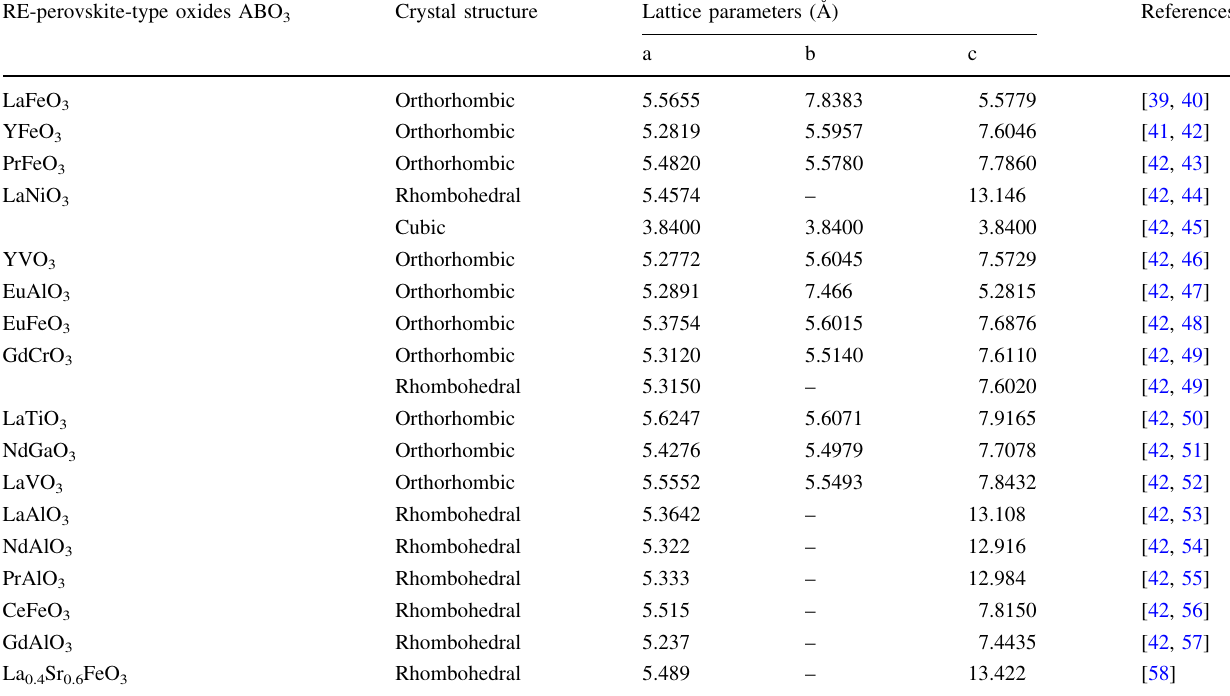
Table 1 Compilation of experimentally determined RE-perovskite crystal structures RE-perovskite-type oxides ABO 3 Crystal